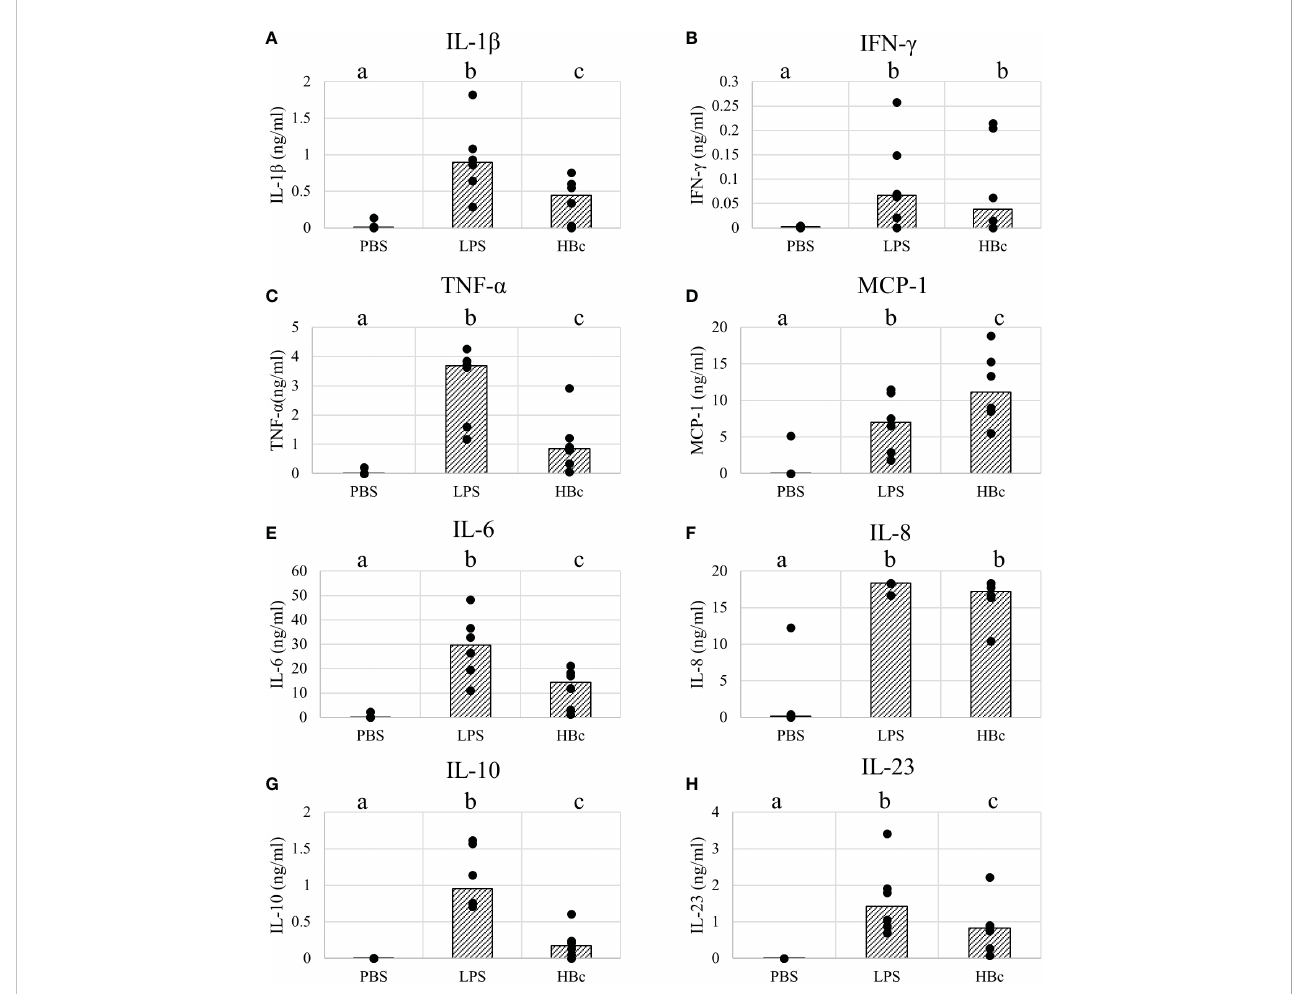
FIGURE 8 Cytokine responses of PBMCs stimulated with HBc VLPs produced in BYL. Cytokines were measured from supernatants of 6 different human blood donors stimulated for 24h with either PBS, 100ng/ml of LPS or 10µg/ml of HBc VLP. The average for each donor (dots) and the median of all donor measurements (bars) are shown for the measured cytokines: (A) Il-1 b (B) IFN- g (C) TNF- a (D) MCP-1 (E) IL-6 (F) IL-8 (G) IL-10 (H) IL-23. Different letters indicate statistically signi fi cant differences between the average of each cytokine concentration for each treatment: PBS, LPS and HBc-treated